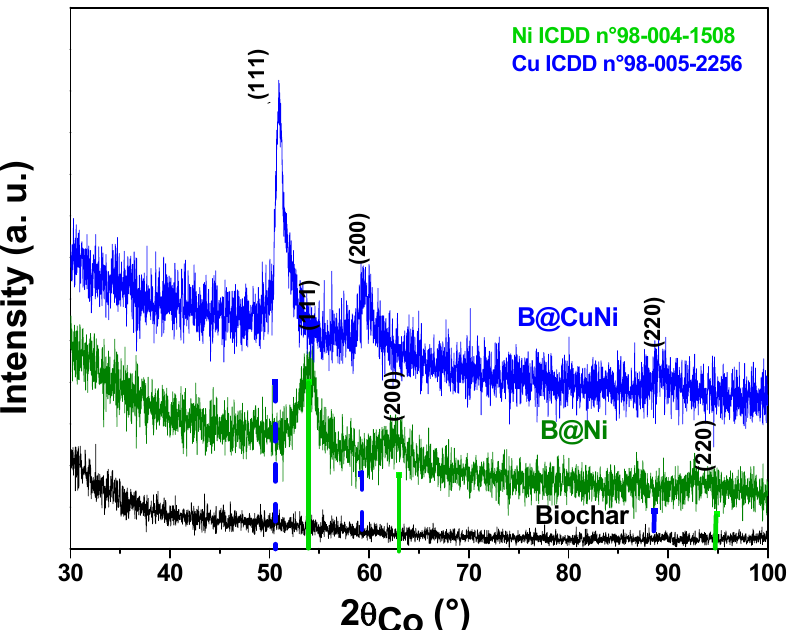
Figure 4. XRD-patterns of B@Ni and B@CuNi samples compared to that of free biochar. The tabulated peak positions of bulk Ni (ICDD n°98-004-1508) and Cu phases (98-005-2256) are given for information.